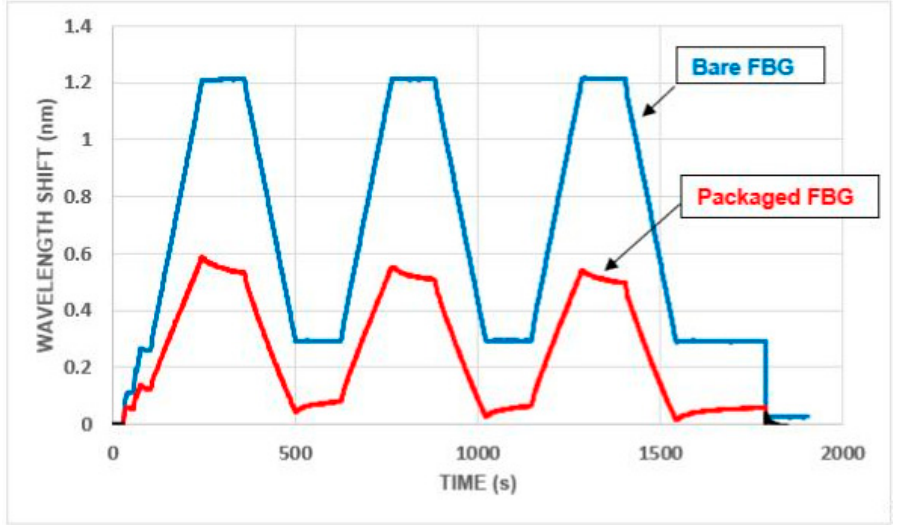
Figure 15. Closed top packages: repeated load cycles to 5.0 kN (total load).